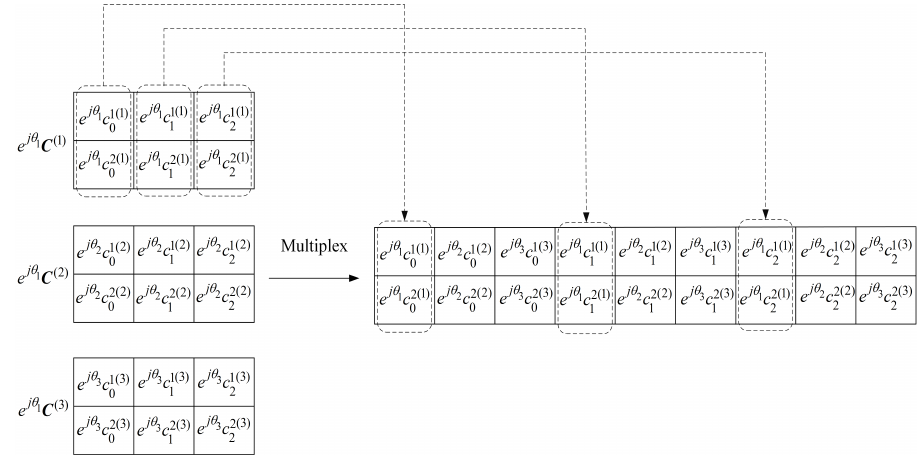
Figure 2. The time-interleaved multiplexer of rotated streams ( L = 3, M = 3, M T =